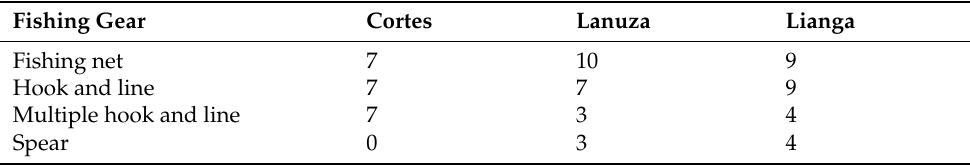
Table 4. Frequently mentioned fishing gear in the three